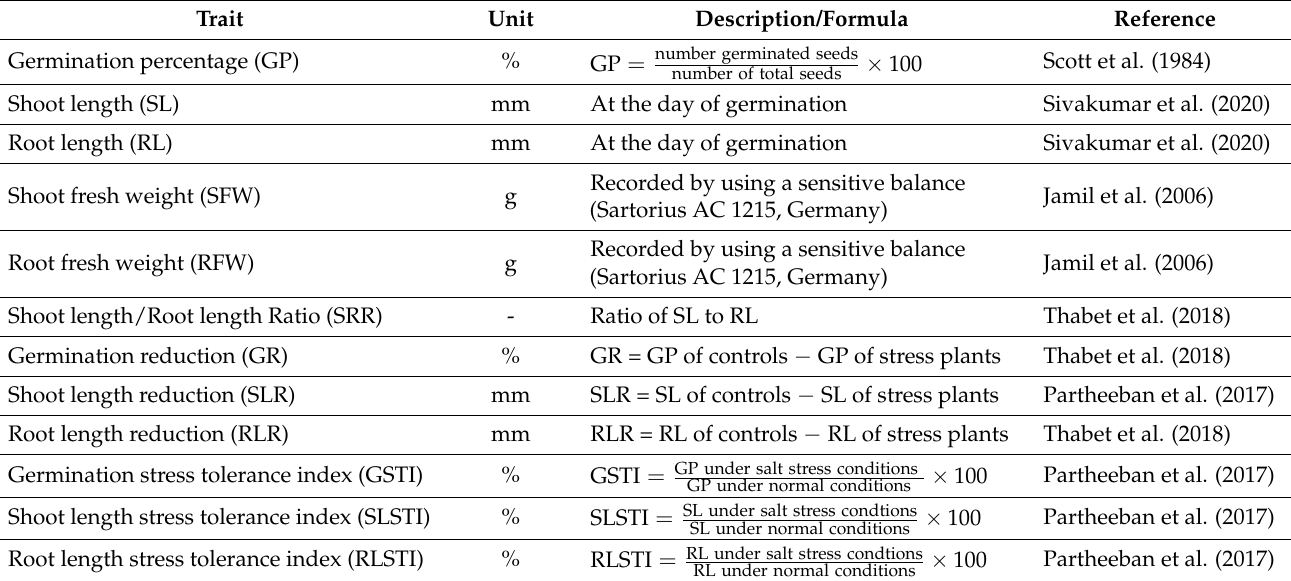
Table 9. Description of the evaluation criteria for salinity tolerance employed in this